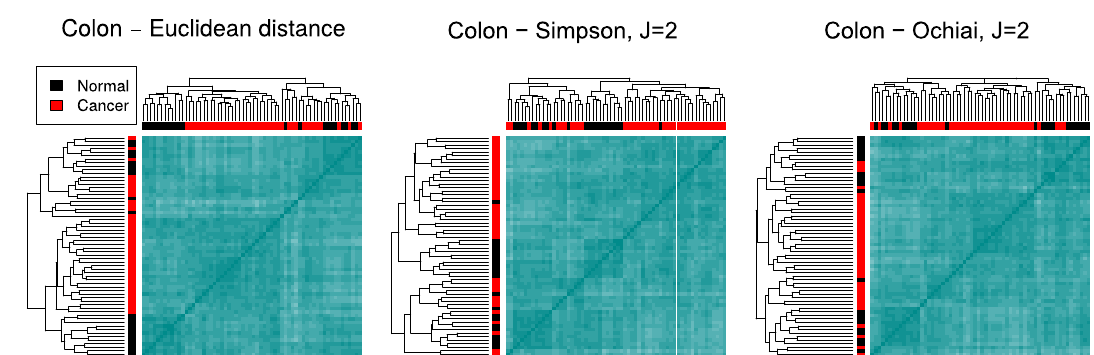
Figure 6. Clustering the colon data set. Dendrograms and heatmaps for the colon data set, using the Euclidean distance (left), the Simpson index (middle) and the Ochiai index (right), for J = 2 . The types of samples are difficult to separate and one branch with mixed leaves emerges in the three